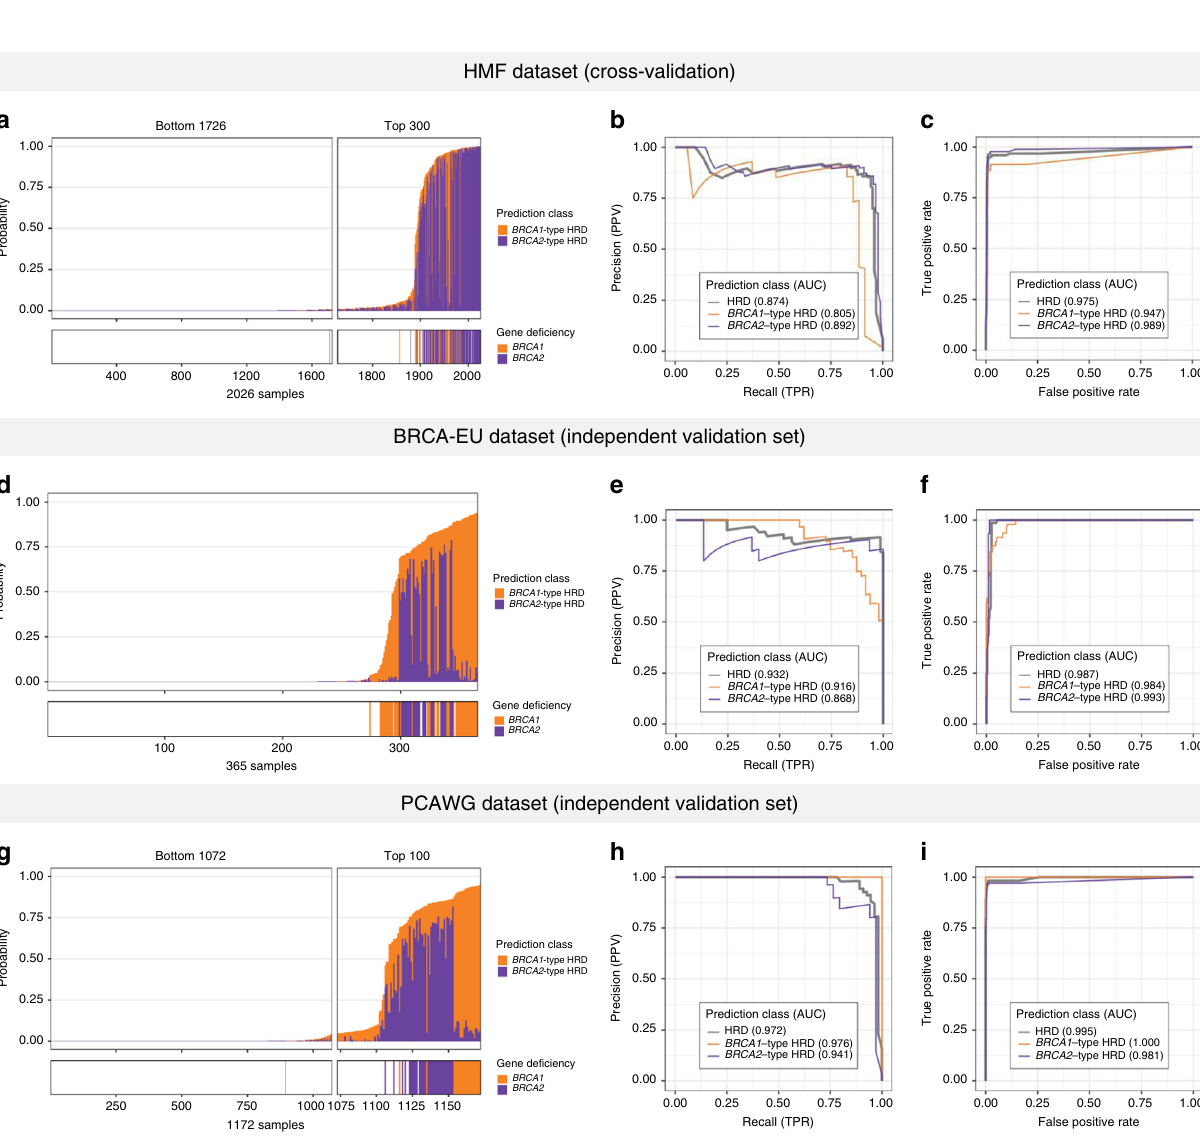
Fig. 2 Performance of CHORD. Performance was determined by 10-fold cross-validation (CV) on the HMF training data, as well as prediction on two independent datasets: BRCA-EU (primary breast cancer dataset) and PCAWG (primary pan-cancer dataset). BRCA-EU and PCAWG samples shown here all passed CHORD ’ s QC criteria (i.e. MSI absent, ≥ 50 indels, ≥ 30 SVs if a sample was predicted HRD). a , d , g The probability of HRD for each sample (total bar height) with each bar being divided into segments indicating the probability of BRCA1 - (orange) and BRCA2 -type HRD (purple). Stripes below the bar plot indicate biallelic loss of BRCA1 or BRCA2 . In a , probabilities have been aggregated from the 10 CV folds. b , e , h Receiver operating characteristic (ROC) and c , f , i precision-recall curves (PR) and respective area under the curve (AUC) values showing the performance of CHORD when predicting HRD as a whole (gray), BRCA1 -type HRD (orange), or BRCA2 -type HRD